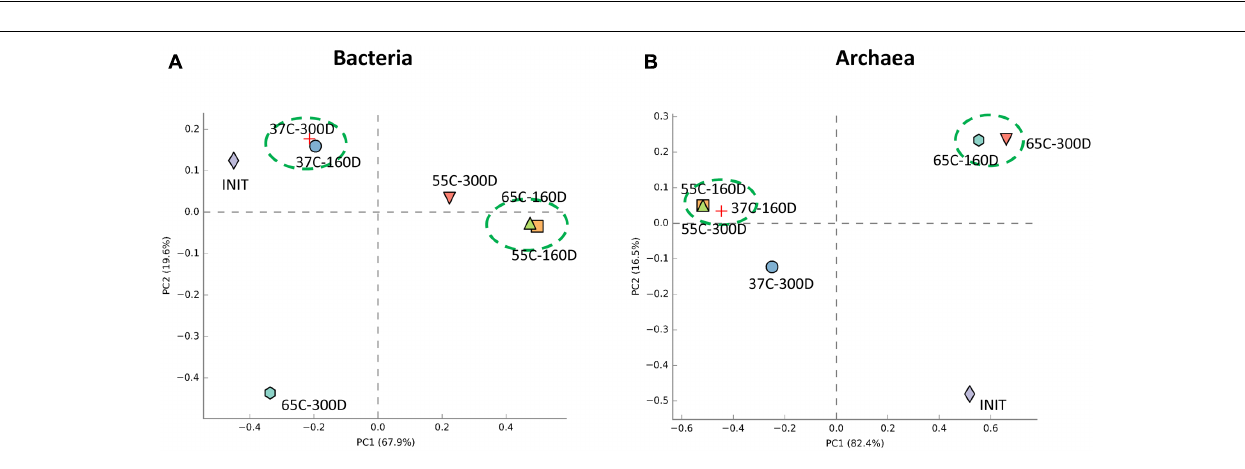
FIGURE 6 | Principal components analysis (PCA) analysis of the bacterial (A) and archaeal (B) communities structure in the different temperature culture microcosms (six samples) compared to the inoculum sample. PCA analysis was carried with STAMP software package using ANOVA as statistical test ( p -value < 0.05) and Turkey-Kramer as post hoc